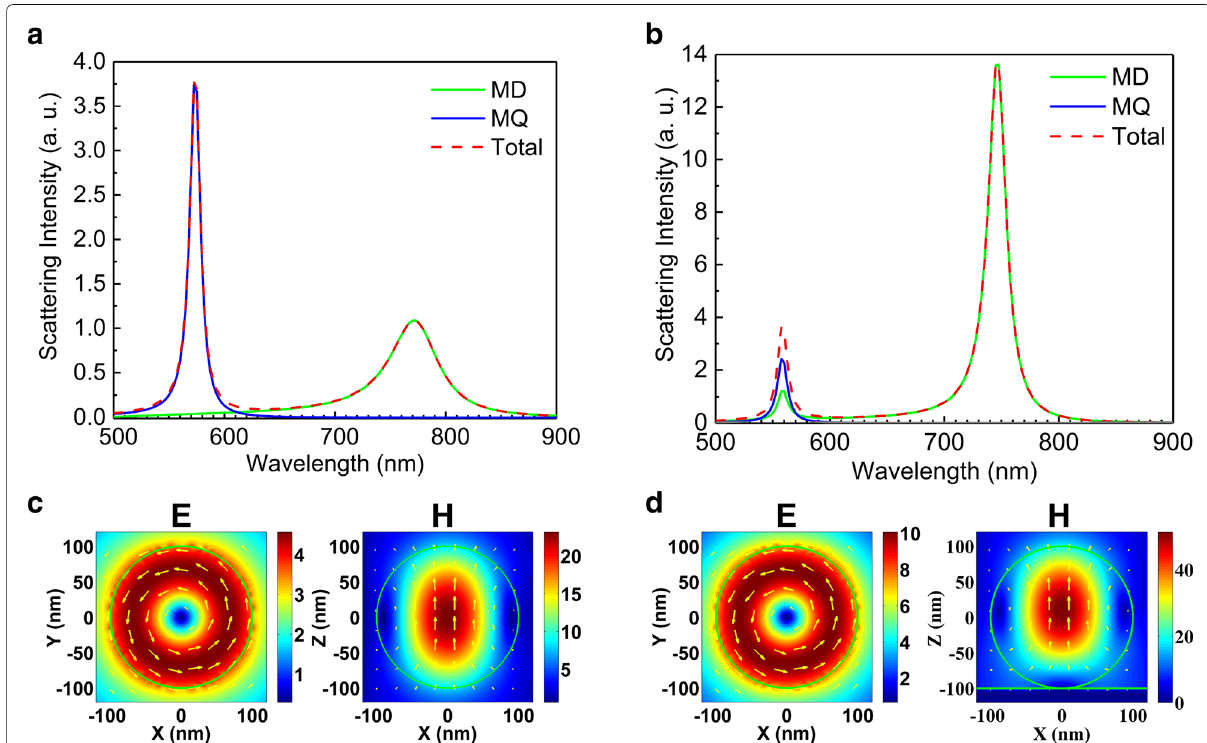
Fig. 2 Multipole decomposition of the total scattering of the Si NS with R = 100 nm suspended in air ( a ), placed on a PEC substrate ( b ), and illuminated by a focused AP beam. The corresponding electric and magnetic field distributions calculated at the MD resonances [775 nm in a and 745 nm in b ] are presented in c and d , respectively